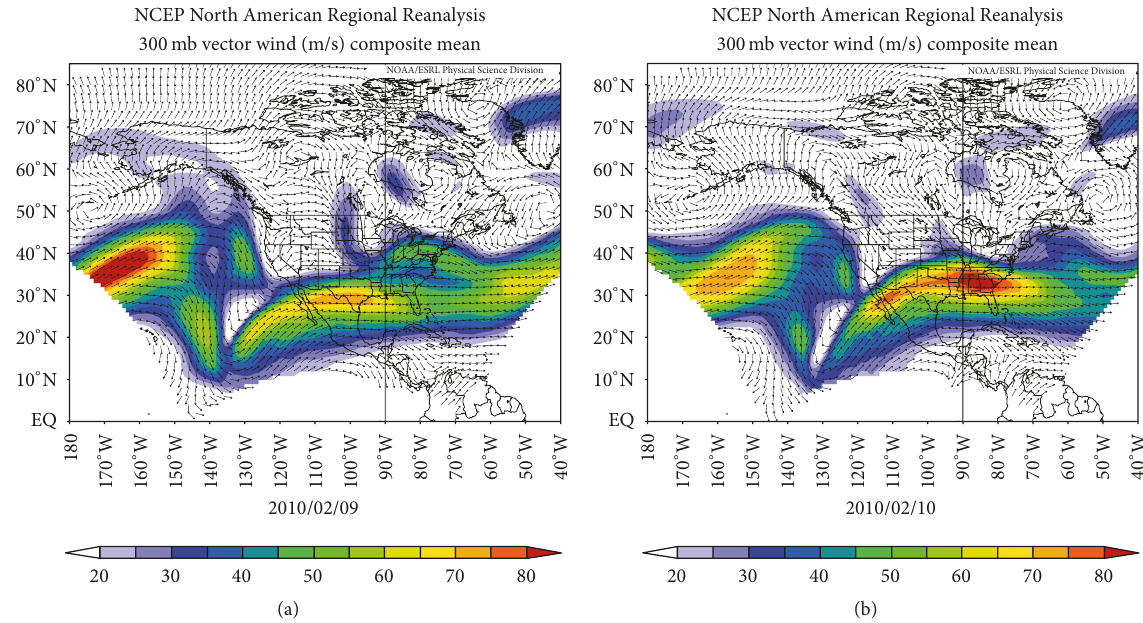
Figure 4: NCEP NARR 300 hPa vector wind composite mean on (a) February 9 and (b) February 10, 2010. The daily composite means are averages of 3 hourly NARR